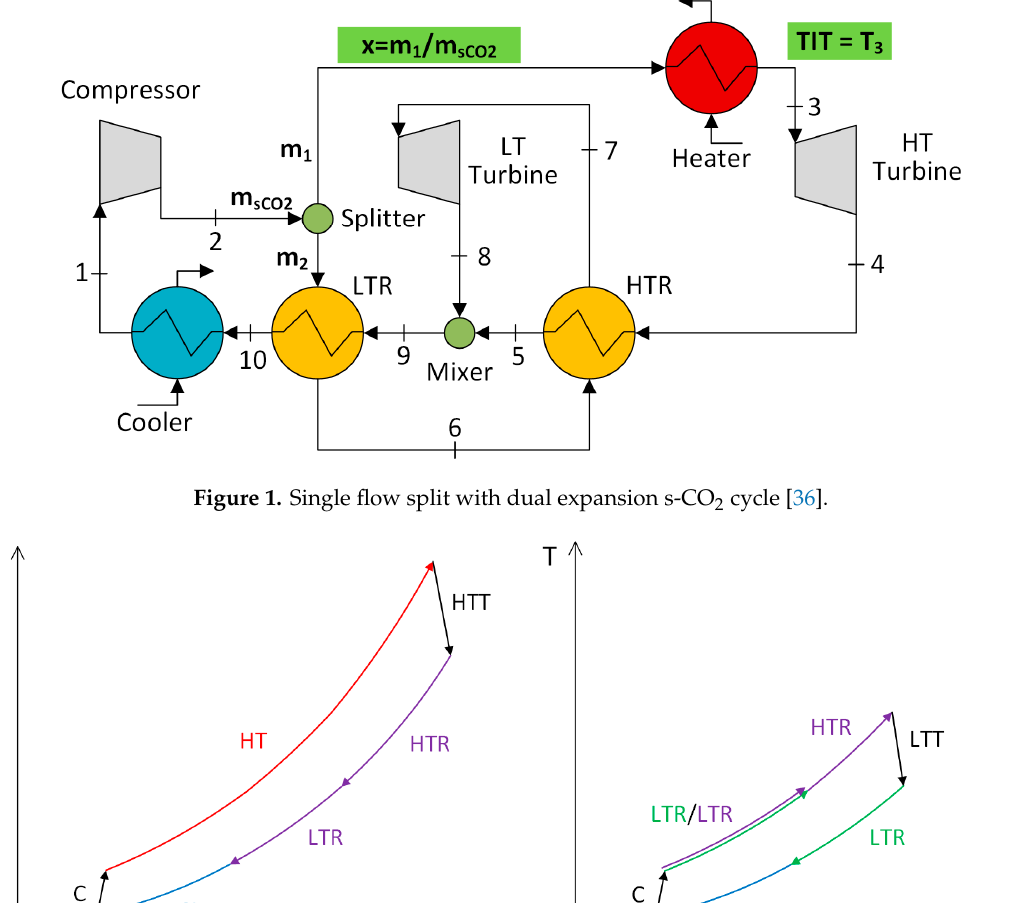
Figure 2. Decomposition of the single flow split with a dual expansion s-CO 2 cycle into two elementary thermodynamic cycles: ( a ) First elementary cycle (topping); ( b ) Second elementary cycle (bottoming).